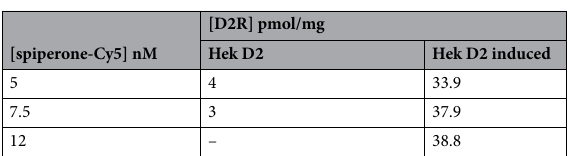
[D2R] pmol/mg [spiperone-Cy5] nM Hek D2 Hek D2 induced 33.9 Table 1. D2R concentration per total protein content. D2R concentration has been reported in relation to total protein content in membrane fragments, and calculated using the intersection point as previously described. Since titration regime was clearly obtained with induced HekD2, this concentration was obtained from three independent replicates for the three different spiperone—Cy5 concentrations (5, 7.5, 12 nM). On the other hand, the result for non-induced HekD2 may be considered as an estimation.